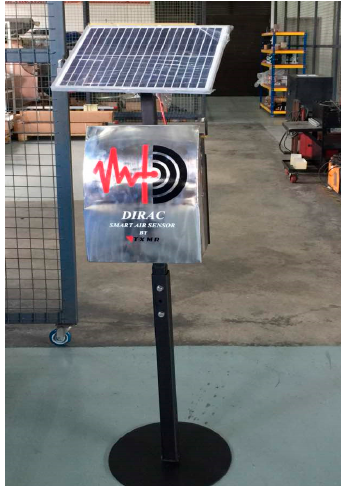
Figure 1. DiracSense.